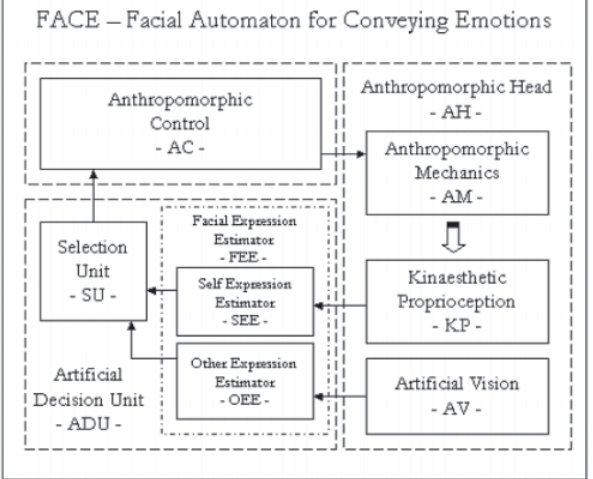
Figure 2 The architecture of